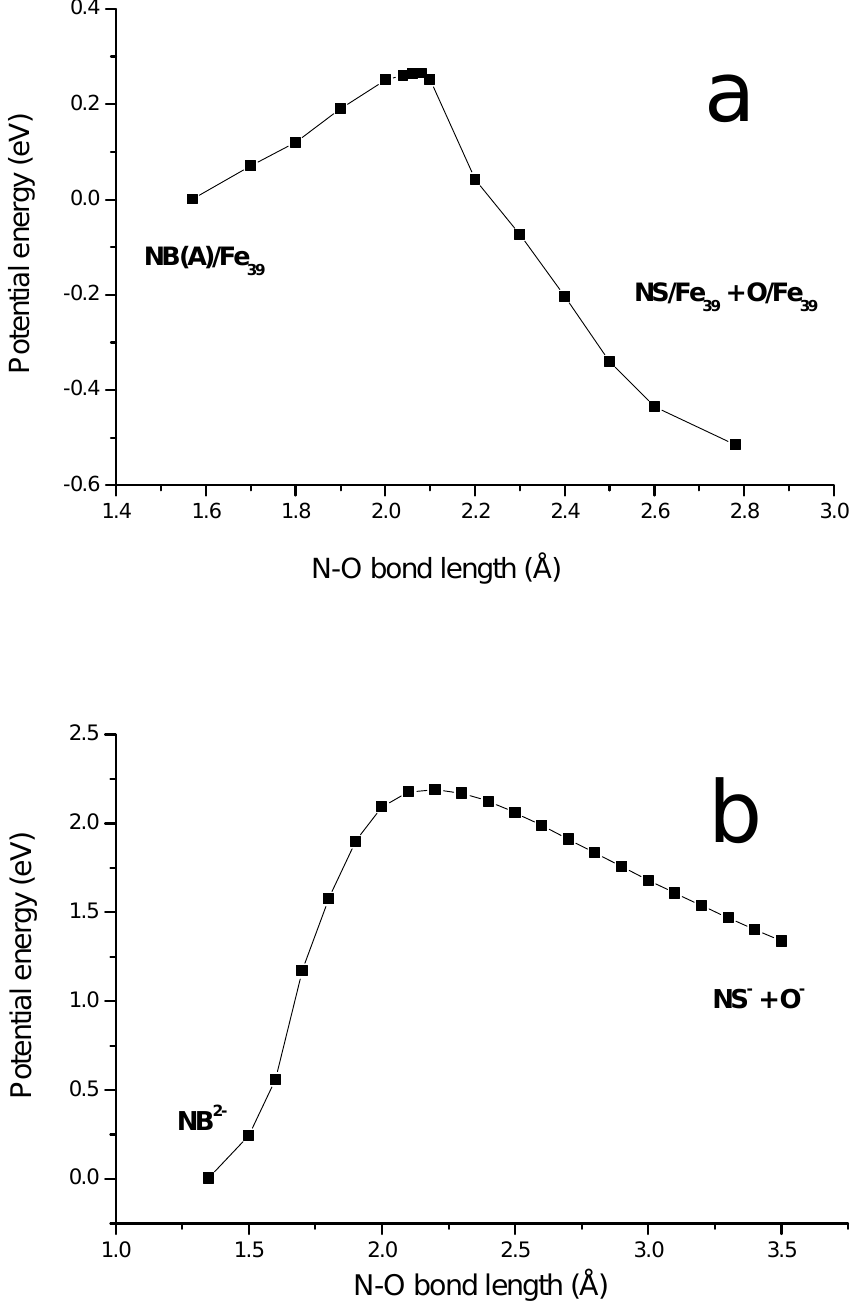
Figure 4. Dissociation of the N-O bond of nitrobenzene. (a) Plot for NB on Fe39. The starting point (taken with zero energy) corresponds to the N-O bond of molecularly adsorbed nitrobenzene. The last one corresponds to the N-O bond dissociated to form nitrosobenzene and oxygen atom adsorbed on iron surface. (b) Potential energy profile calculated for different N-O bond of isolated nitrobenzene having total charge of –2 and spin multiplicity of